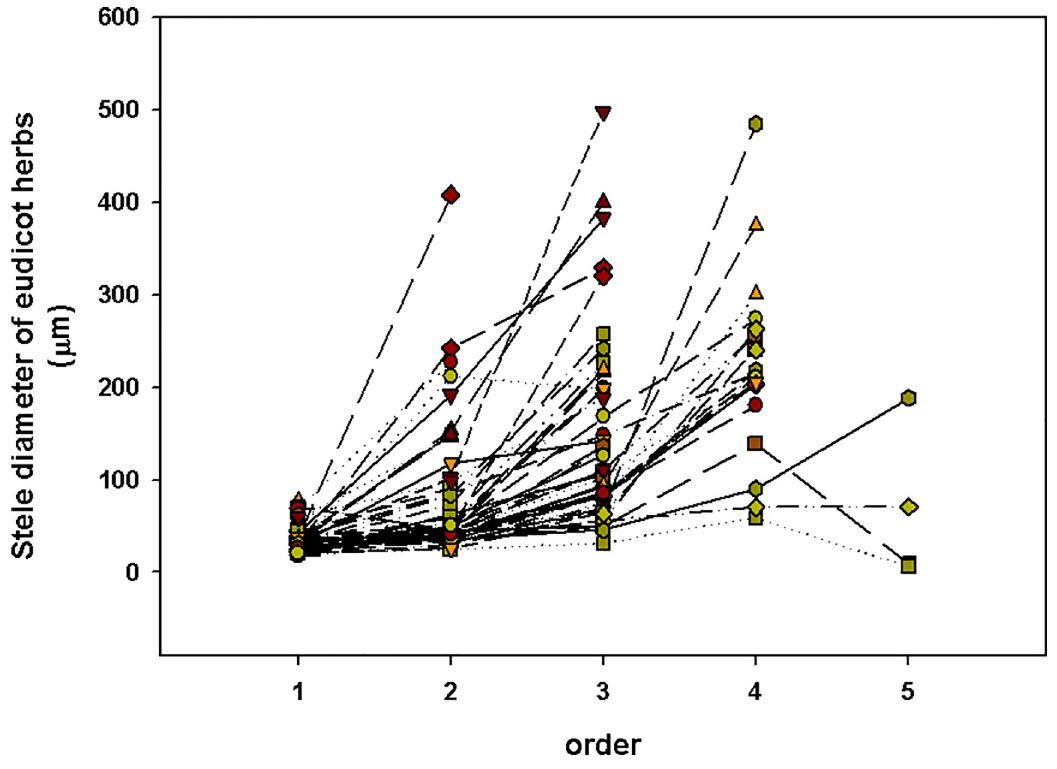
S4 Table. Test of normal